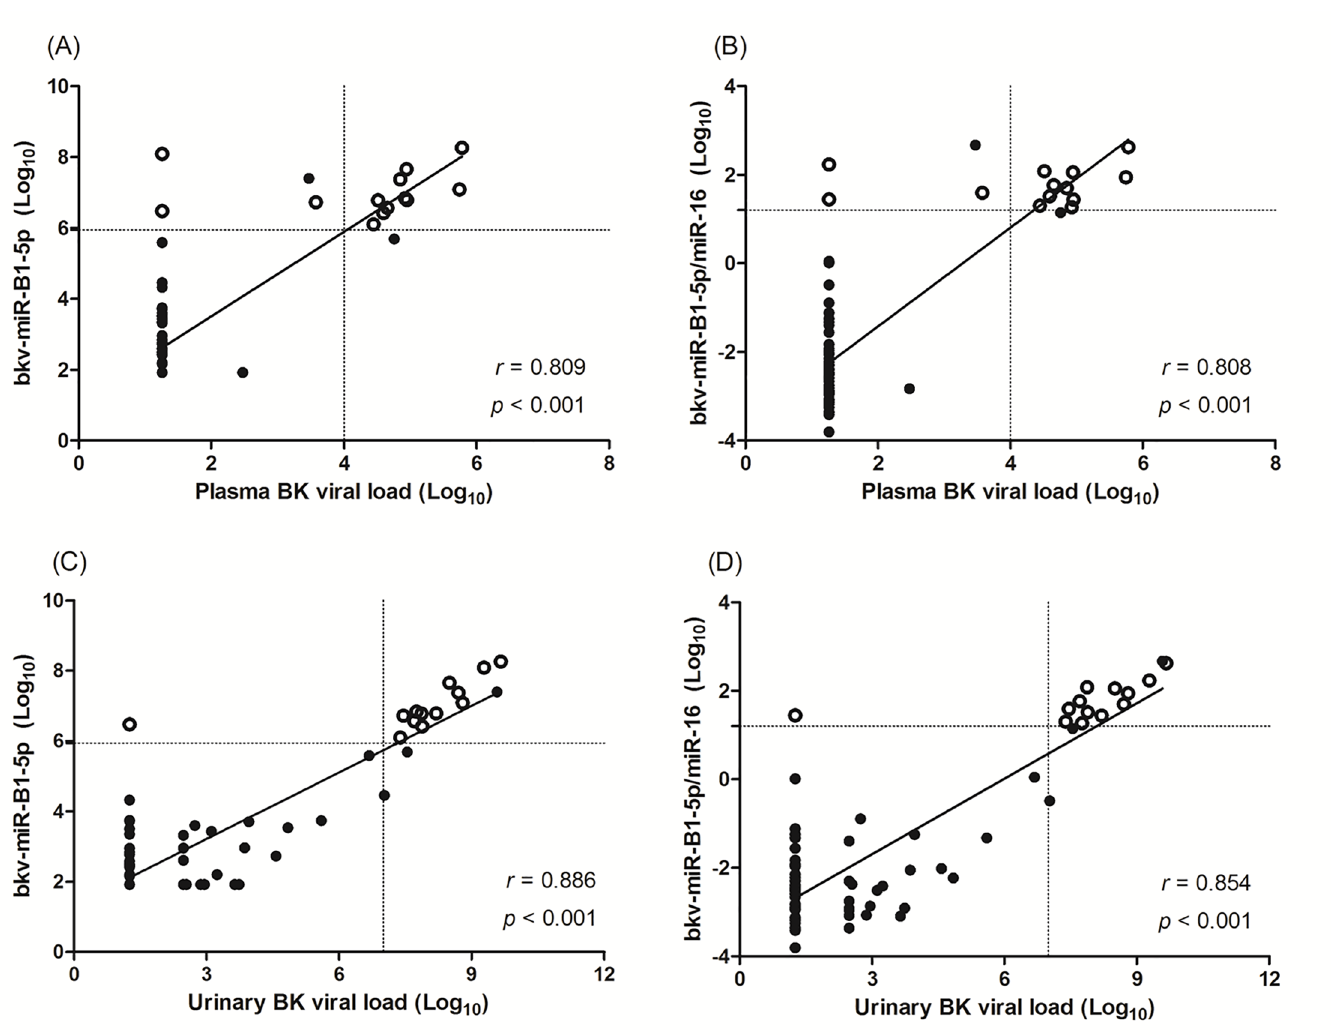
Fig 3. Correlation analysesbetween urinary exosomal bkv-miR-B1-5p, bkv-miR-B1-5p/miR-16 and BK viral load. (A) and (B) A significantpositive correlationbetweenbkv-miR-B1-5p and plasma BK viral load was shown. (C) and (D) There was also a positive correlationbetweenbkv-miR-B1-5p and urinary BK viral load. Open circles represent patients with BKVN and closed circles represent the remainingpatients. Dotted lines signify the cut-off values for each test in this study (5.9 log 10 copies/mL for bkv-miR-B1-5p, 1.2 log 10 copies/mL for bkv-miR-B1-5p/miR-16,4.0 log 10 copies/mL for plasma BK viral load, and 7.0 log 10 copies/mL for urinary BK viral